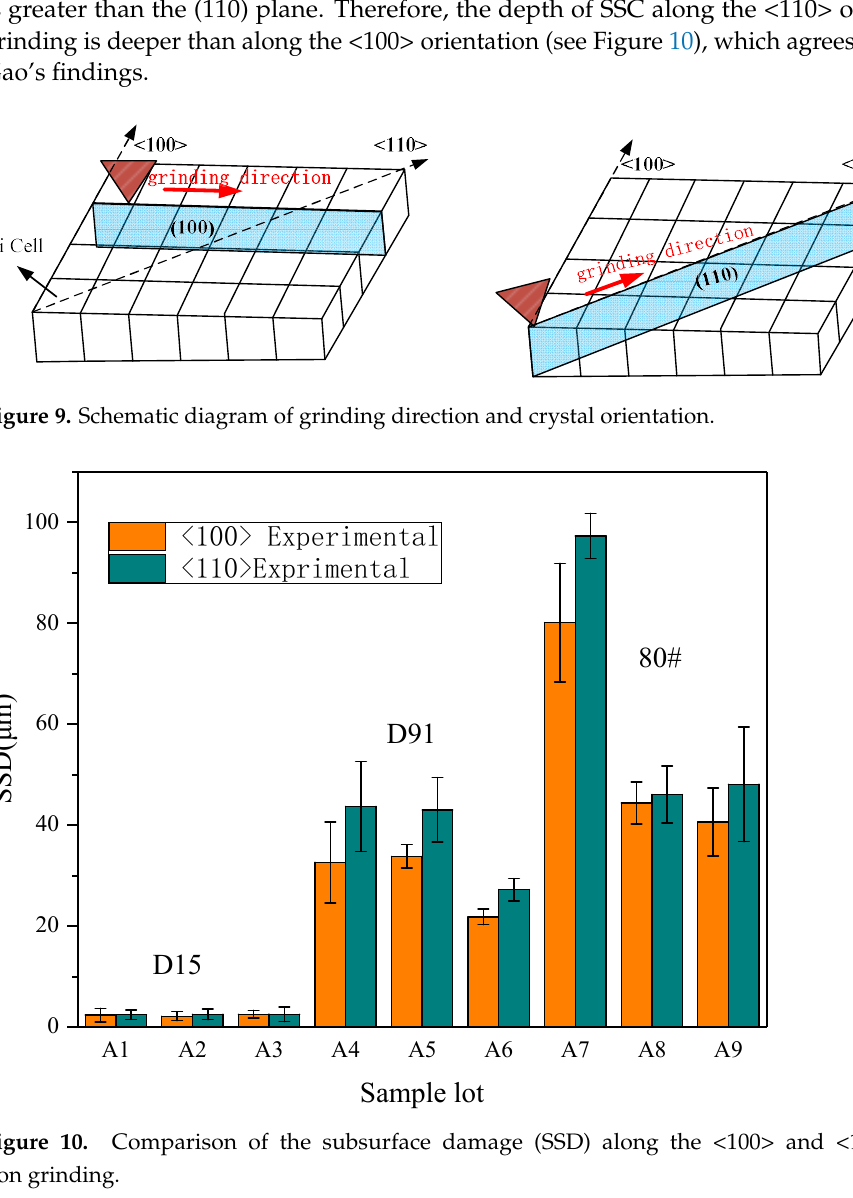
Figure 8. Comparison of experimental and predicted results.